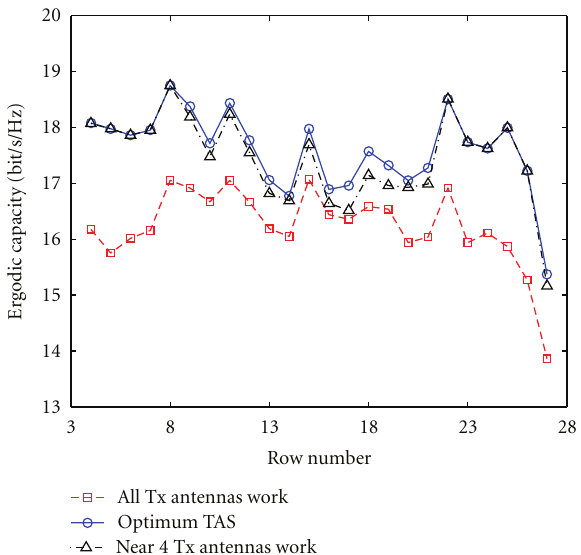
Figure 4: TAS capacity gains with di ff erent transmit SNRs using Rx3, Rx4, and